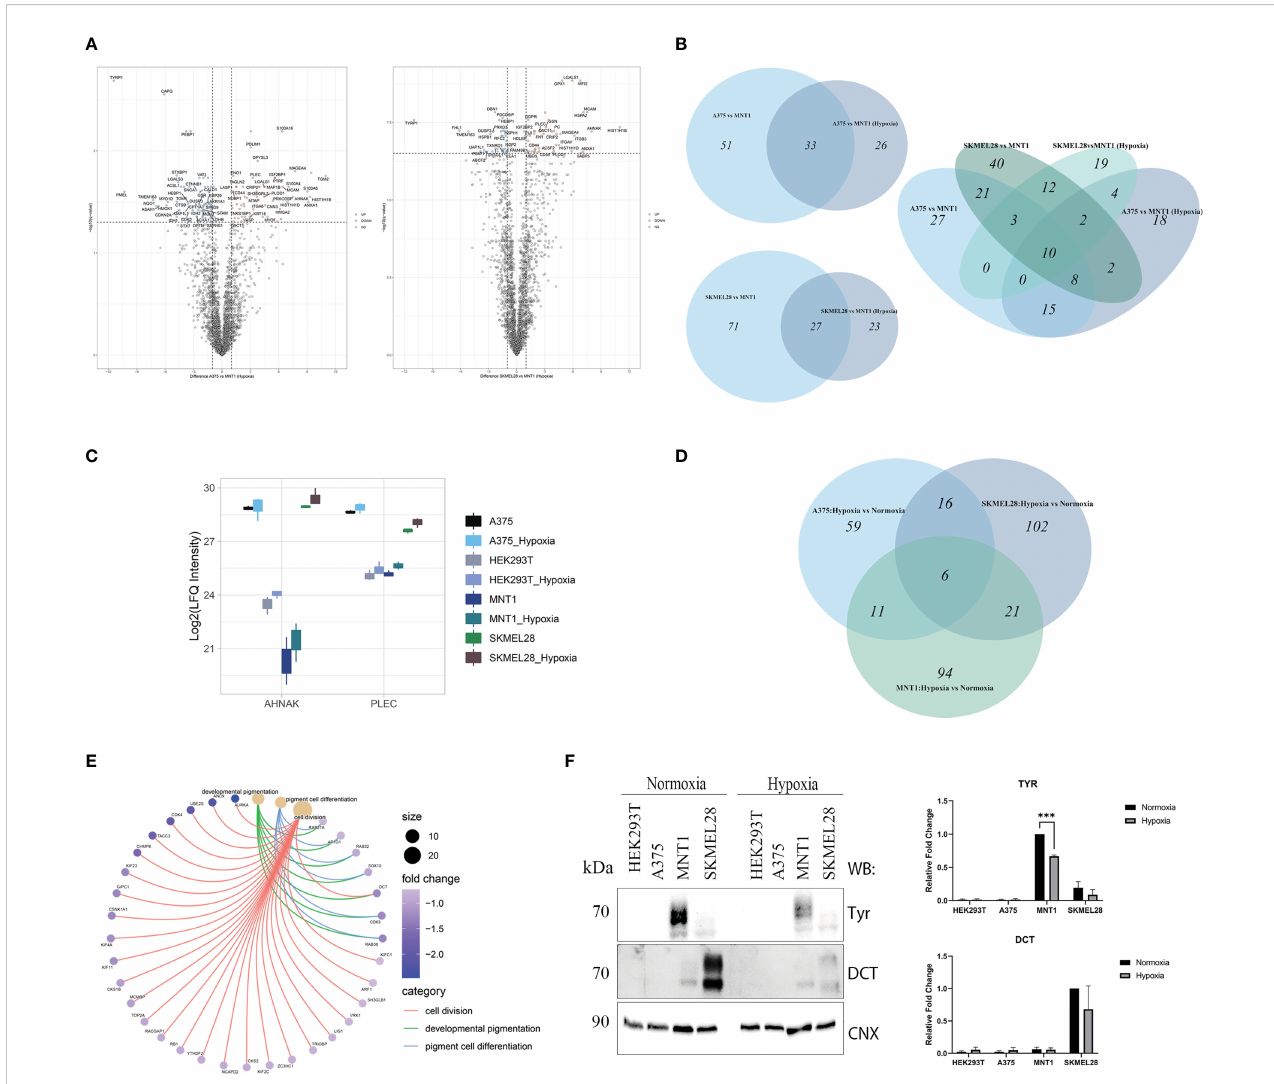
FIGURE 5 LC-MS/MS proteome analysis of melanoma cells in hypoxia. (A) Volcano plots representing the protein expression changes under hypoxia in the comparisons between amelanotic and highly pigmented cells (pairwise comparisons, q value<0.05, absolute log2FC ≥ 1) (Supplementary Table 1, S1). (B) Venn diagrams depicting unique and shared sets of up-regulated proteins from the comparisons between amelanotic and highly pigmented cells in normoxia and hypoxia (C) Box plot of log2 transformed LFQ intensity level of AHNAK and PLEC. (D) Venn diagram depicting unique and shared sets of up-regulated proteins in melanoma cell lines after cell exposure to hypoxia (log2FC ≥ 1). (E) Cnet plot depicting the linkages between core enriched proteins for processes that were signi fi cantly enriched, coming from the comparison between melanotic cells cultured under hypoxia vs normoxia (Supplementary Table 1, GSEA MNT1 Hypoxia vs Normoxia). (F) Western blot analysis of TYR and DCT under normoxia and hypoxia. Calnexin was used as loading control. Western blot densitometry band quanti fi cation for TYR and DCT is presented as the mean ± SEM (two-way ANOVA with Sidak multiple comparisons test; ***p < 0.001,